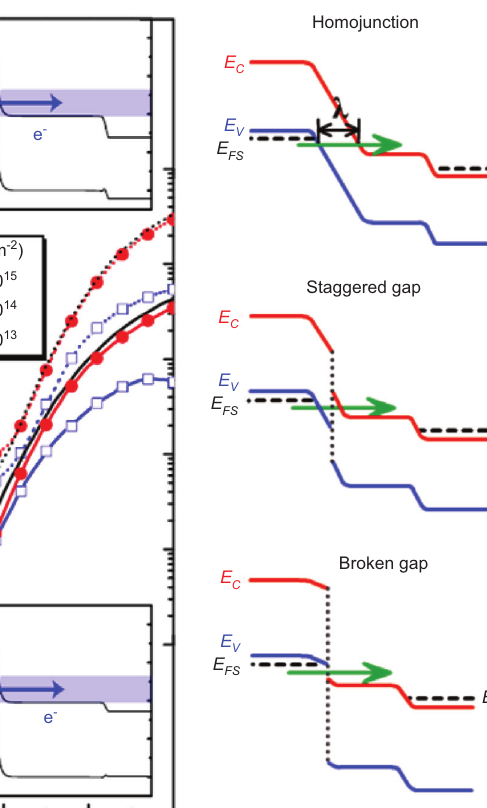
Figure 10 The schematic band diagrams of (A) homojunction, (B) staggered gap, and (C) broken gap TFET at ON-state. For homojunc- tion TFETs, the same material was used for source, channel, and Ge n-TFETs with Figure 9 (A) Transfer characteristics of Si drain regions. Homojunction TFETs usually exhibit low ON-state 0.5 0.5 BF /cm 2 BF /cm 2 [1 × 10 15 + source/drain implantations of 1 × 10 15 + current due to the relatively large tunneling barrier width ( λ ). For 2 2 (black), 1 × 10 14 (red), and 1 × 10 13 As + /cm 2 (blue), respectively]. Solid staggered gap TFETs, the source/channel junction is formed by two = 0.5 V and dotted for V = 1.7 V. (B–E) The simu- curves are for V different materials with a type-II staggered band alignment (like DS DS lated band structure displayed in the insets indicate the influence of In Ga As/GaAs Sb ). The tunneling barrier width ( λ ) of a staggered x 1-x y 1-y the drain dopant concentration on the tunneling current: (B) and (C) gap TFET is reduced compared with the homojunction, resulting in = N = 2 × 10 20 cm -3 ; (D) and (E) N = 2 × 10 20 cm -3 , N = 1 × 10 19 cm -3 . The N a much higher I . For broken gap TFET, the source/channel tunnel A D A D ON = 0.1 V, V = -0.5 V and (C) and (E) bias conditions are (B) and (D) V junction is formed by a type-III (like InAs/GaSb) heterostructure, DS GS which further reduces the tunneling barrier width ( λ ) and leads to even higher I . However, due to the normally ON feature of the ON broken gap TFET, an additional gate voltage is needed to turn OFF this type of